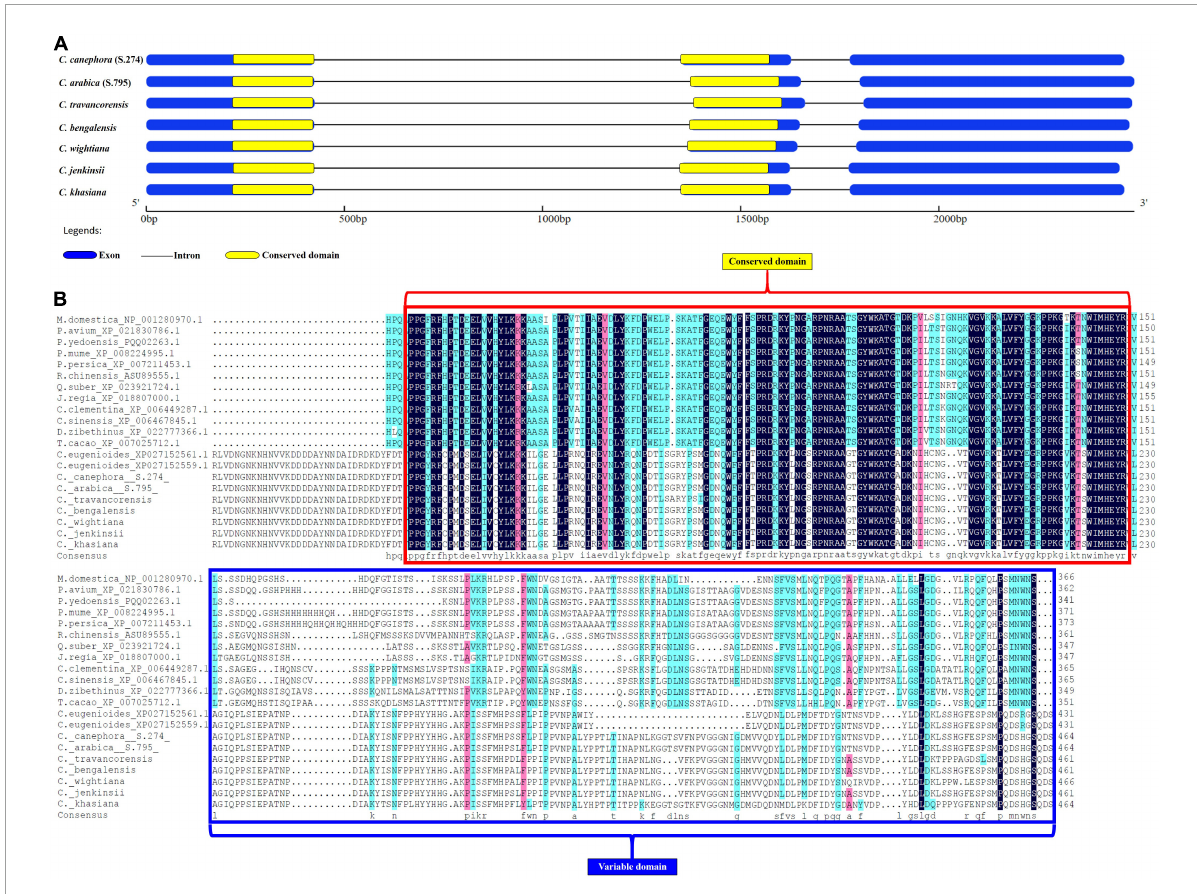
FIGURE5 (A) Figure depicting the exon, intron and conserved domain of full length NAC25 gene isolated from seven coffee species. (B) Comparison of NAM conserved domain of NAC25 gene with other crop